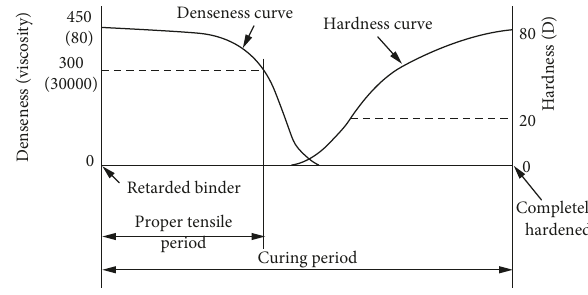
Figure 2: The retarder curing